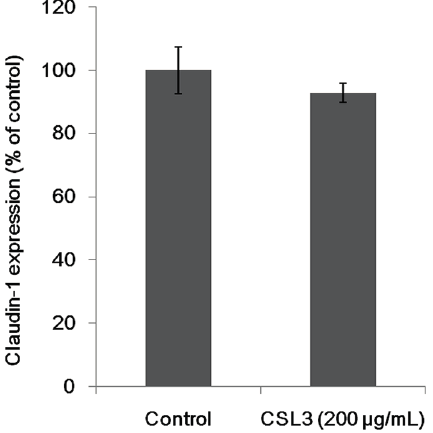
Figure 8. Effect of CSL3 on the expression level of claudin-1.The cells were incubated in HBSS for 2 h in the absence or presence of CSL3 (200 µg/mL). The results are shown as a percentage of the control (without lectins) values, and are the means ± SD of six different determinations. * p < 0.05 compared with control value.